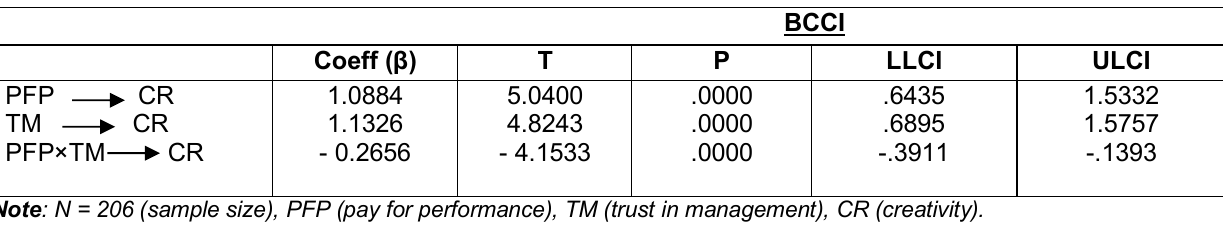
Table 3: Coefficients for the moderating effects